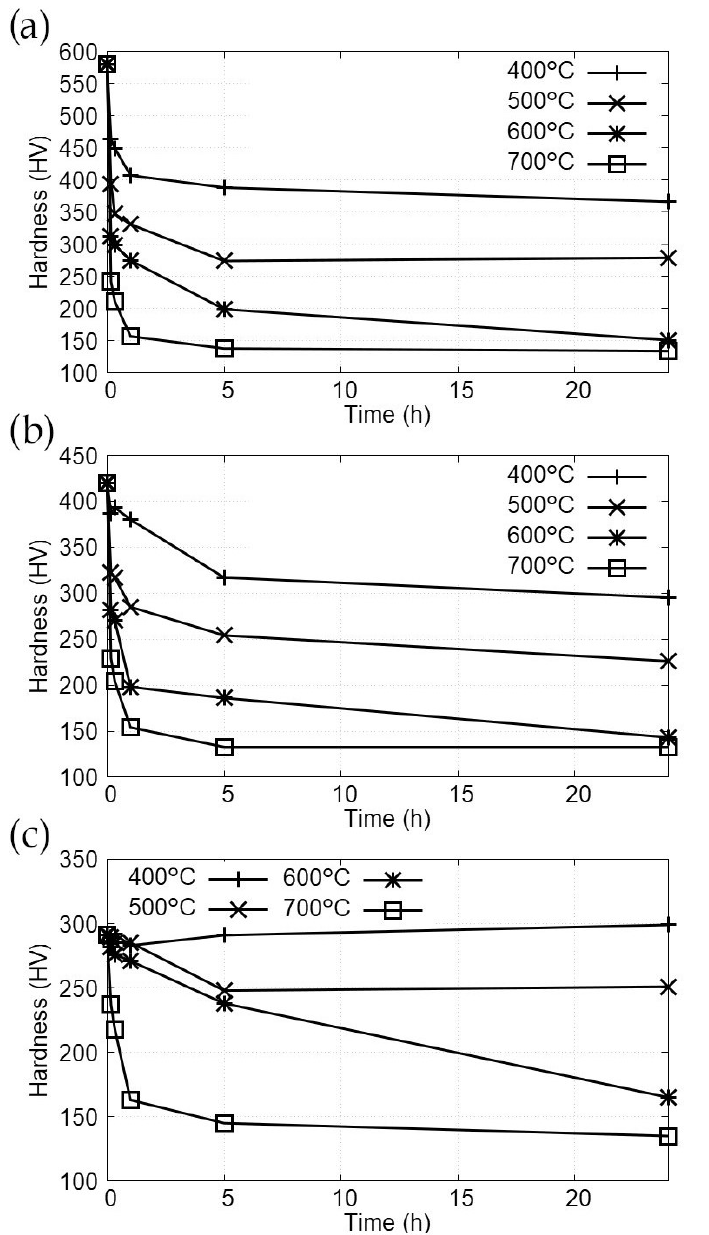
Figure 5. Evolution of hardness with time and temperature ( a ) Samples quenched in water. ( b ) Sam- ples cooled under air flow. ( c ) Samples quenched in water after 5 h at 880 ◦